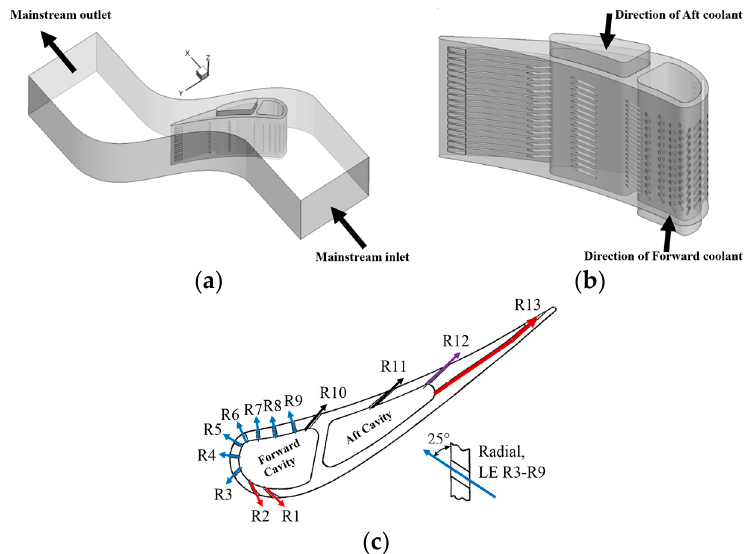
Figure 2. ( a ) Mainstream cascade; ( b ) Vane configuration; ( c ) Cross-section area of the vane at midspan.